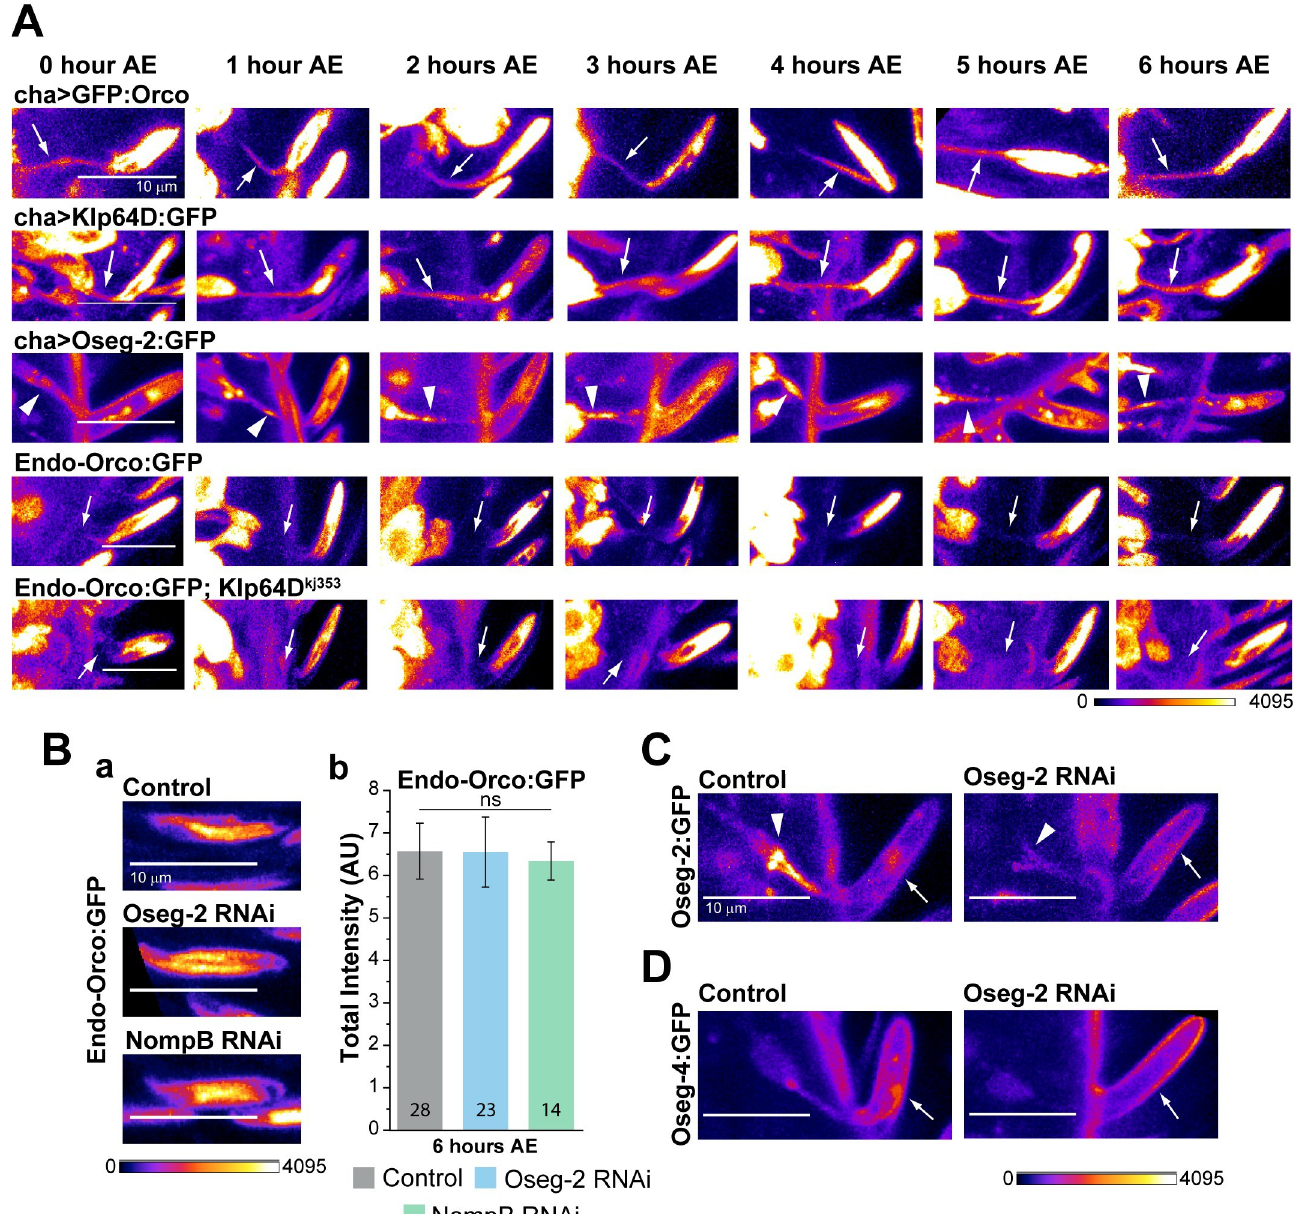
Fig 5. IFT172/Oseg2 is not required for Orco enrichment in the olfactory cilia. (A) The patterns of GFP:Orco, Oseg2:GFP, KLP64:GFP, and Endo-Orco:GFP localizations along the olfactory cilia during 0–6 hour AE in the wild-type ( cha > ) and Klp64D kj353 mutant backgrounds. Fine arrows indicate relatively uniform localisation of KLP64D:GFP, Endo-Orco:GFP and GFP:Orco and the arrowheads indicate clearly discernible Oseg2:GFP puctae in the inner segment. (B) Endo- Orco:GFP localisation in ab1-type s . basiconica from the control ( orcoGal4 , Endo-Orco : GFP/+; UAS-Dicer/+ ), Oseg2 RNAi ( orcoGal4 , Endo-Orco : GFP/UAS-Oseg2 RNAi; UAS-Dicer/+ ) and NompB RNAi ( orcoGal4 , Endo-Orco : GFP/UAS-NompB RNAi; UAS-Dicer/+ ) backgrounds, respectively, at 6 hours AE (a). Histograms indicate Endo-Orco:GFP fluorescence intensity (mean ± S.D.) in the cilia in the control, Oseg2 and NompB RNAi backgrounds at 6 hours AE (b). The pairwise significance of difference was estimated using one-way ANOVA, and the p-values ( � p < 0.05, �� p < 0.01, and ��� p < 0.001) are shown on the plots. (C, D) Oseg2: GFP and Oseg4:GFP localisations at the basal body (arrowhead) and cilia (arrow) in the control and Oseg-2 RNAi (driven by orcoGal4 ) backgrounds. Images are shown in a false colour intensity heat map (FIRE, ImageJ), arrowheads indicate the dendritic knob, arrows indicate the OS and scale bars indicate 10 μ m. Number of sensillae (n) quantified is indicated on the graphs.